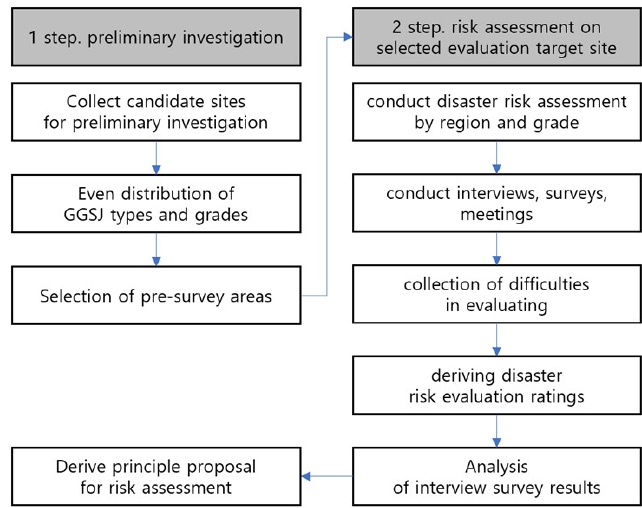
Figure 1. Flow chart of the research